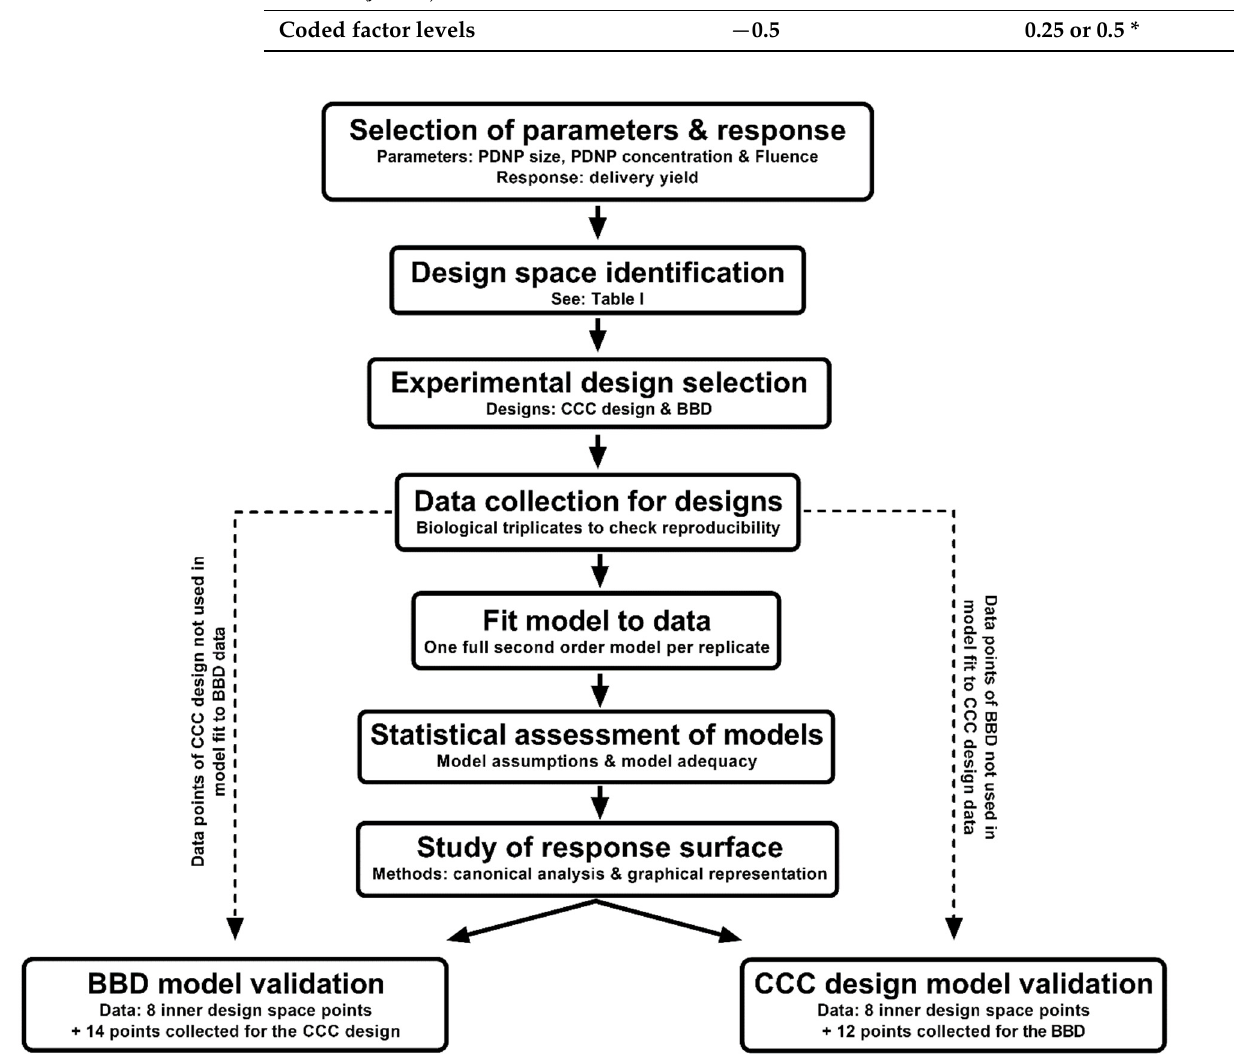
Figure 6. Scheme representing the complete RSM procedure used in this study and clarifying the model validation